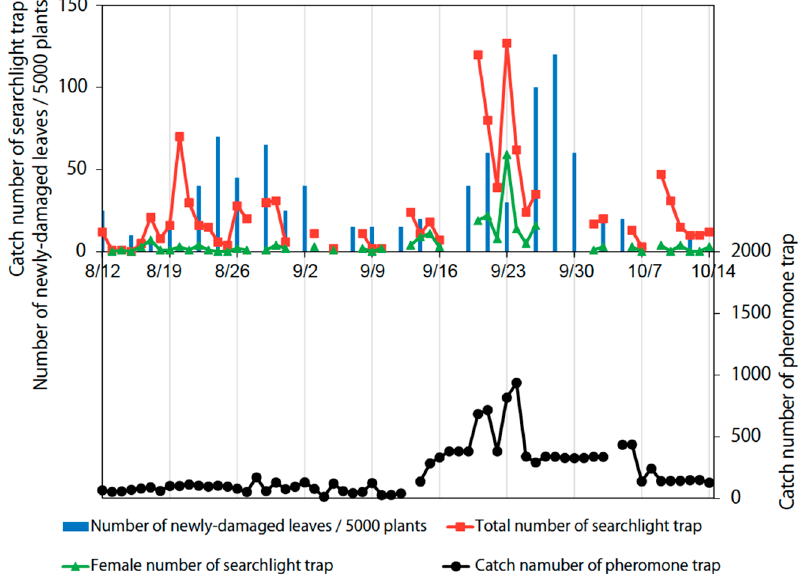
Figure 2. Temporal variation of S. litura catch numbers caught by the searchlight and pheromone traps, and numbers of newly damaged leaves per 5000 soybean plants in 2016 (Saga, western Japan).